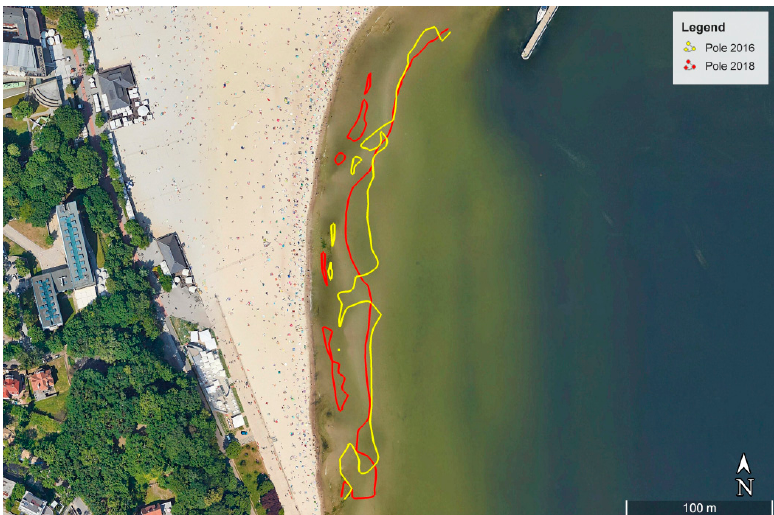
Figure 10. The course of the territorial sea baseline of the waterbody adjacent to the municipal beach in Gdynia determined by the geodetic method in 2016 (yellow) and in 2018